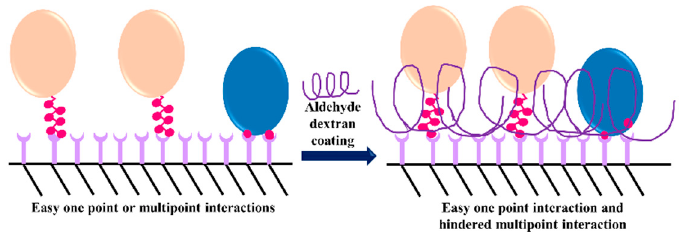
Figure 9. Improved selectivity of highly activated IMAC supports by dexOx coating.